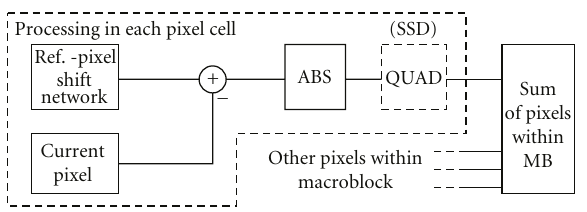
Figure 1: Cell-level functionality required for